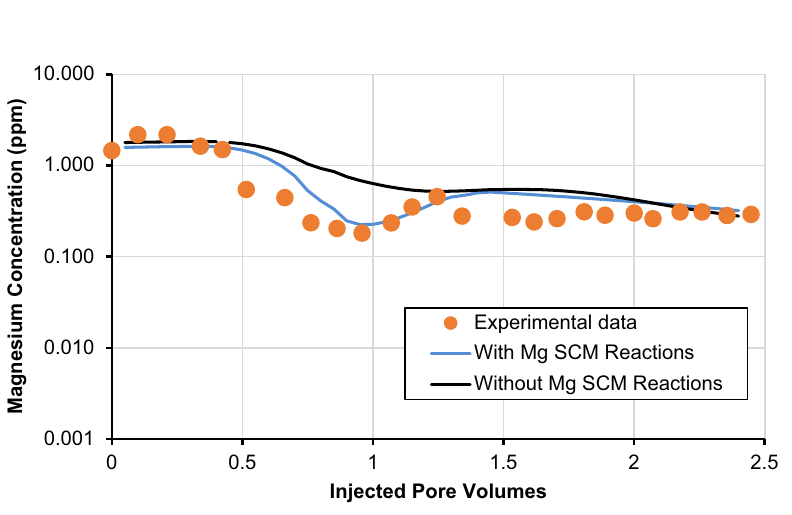
Figure 3. Effect of magnesium ion concentration in effluent and comparison of with and without the usage of magnesium surface complexation